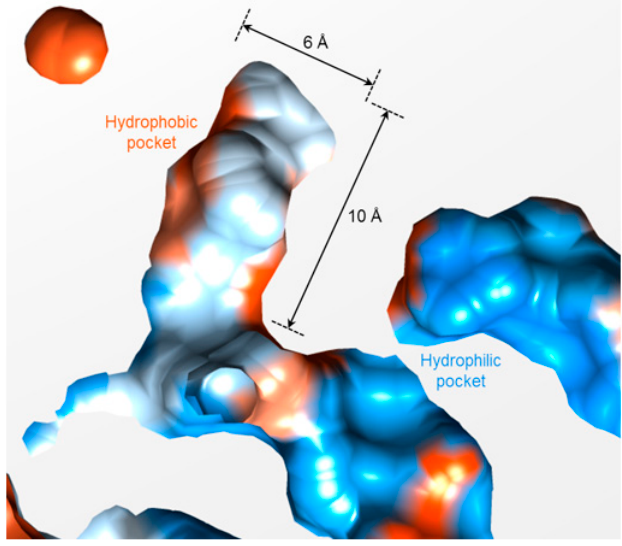
Figure 3. Hydrophobic and geometric properties of the binding pocket. Hydrophilic and hydrophobic regions are shown in blue and orange, respectively.